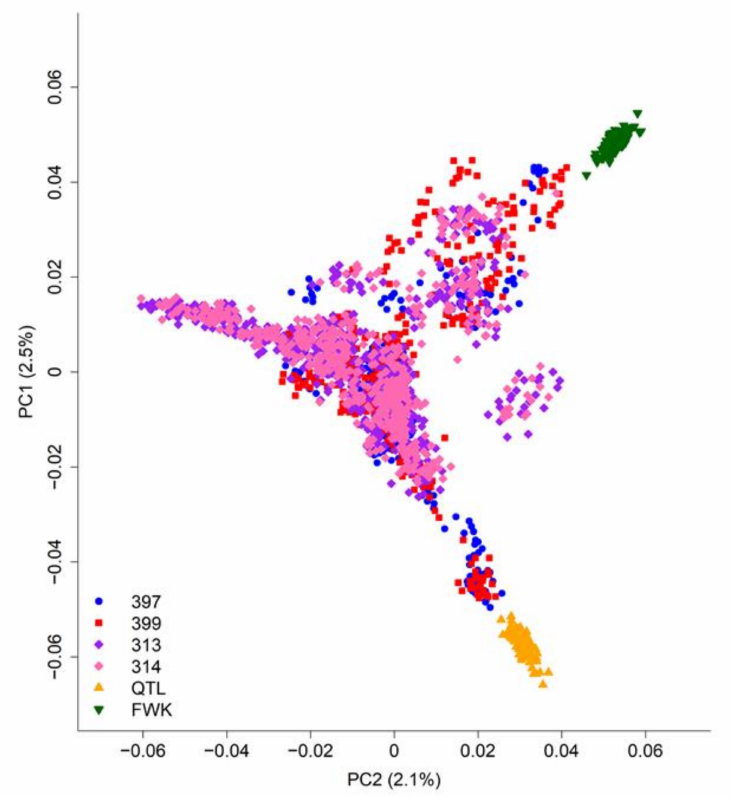
Figure 2. Principal component analysis of population structure for all genotyped radiata pine trees (Table 1). The percentages of single-nucleotide polymorphism (SNP) variation captured by the first two principal components (PC1 and PC2) are shown in